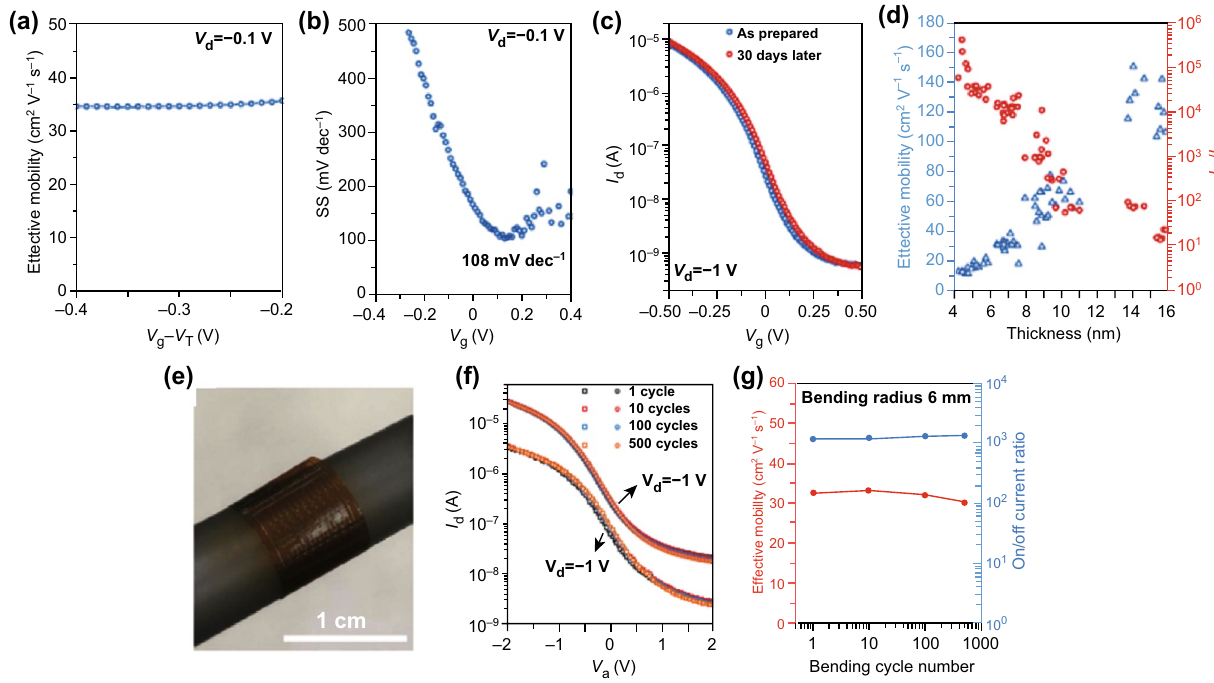
Fig. 13 a , b Effective mobility and subthreshold swing of Te‑based (8 nm) FETs. c Drain current and gate voltage ( I d – V g ) measurement of Te‑based (8 nm) FETs with a time period of 30 days. d Thickness dependence of the on/off current ratio (red) and effective mobility (blue) for Te‑based FETs. e Optical image of Te‑based FETs on a Kapton substrate. f , g Electrical properties of the device after 500 bending cycles with a radius of 6 mm. Adapted with permission from [178]. Copyright 2020, Nature publishing Group. (Color figure